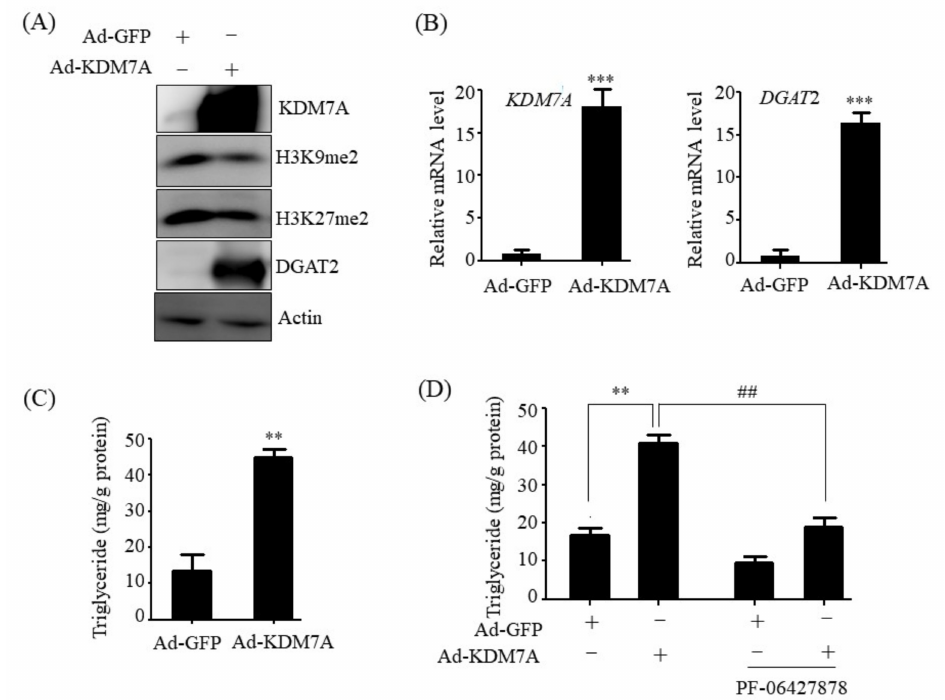
Figure 2. KDM7A overexpression increases DGAT2 expression and intracellular TG levels in AML12 cells. AML12 cells were infected with Ad-GFP or Ad-KDM7A. ( A ) Protein levels of KDM7A, H3K9me, H3K27me2 and DGAT2 were measured by Western blotting. ( B ) mRNA levels of KDM7A and DGAT2 were measured by qPCR. ( C ) Intracellular TG levels were measured using a TG assay kit. Data are presented as the mean ± SD from three independent experiments. ** p < 0.01, *** p < 0.001 vs. control (Ad-GFP). ( D ) AML12 cells were infected with Ad-GFP or Ad-KDM7A and then treated with PF-06427878 for an additional 24 h. Intracellular TG levels were measured using a TG assay kit. Data are presented as the mean ± SD from three independent experiments. ** p < 0.01 vs. control (Ad-GFP), ## p < 0.01 vs. Ad-KDM7A without PF-06427878